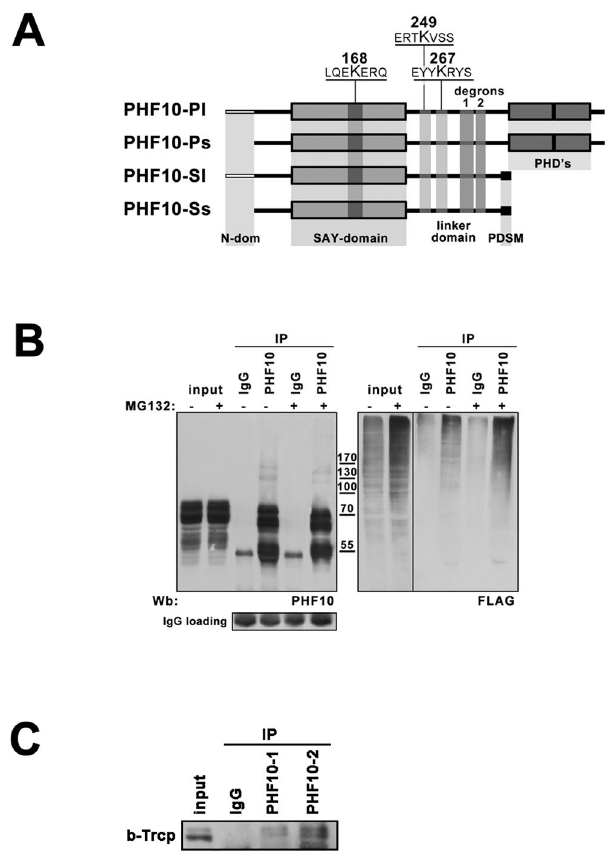
Figure 3. PHF10 is degraded via β -TrCP targeted ubiqutination. ( A ) The schematic representation of localization of ubiqutination sites and β -TrCP degrons within PHF10 isoforms. Sequences containing ubiquitinated lysines (according to Phosphosite database) are underlined. The ubiquitinated lysines and β -TrCP degrons are common for all PHF10 isoforms. ( B ) The HEK293 cells were transfected with FLAG- ubiquitin and treated (if indicated) with 10 µ M MG132 for 8 hrs. Then PHF10 was immunoprecipitated from control and treated HEK293 extracts with Protein A –Sepharose bound anti-PHF10 antibodies. IgG coupled to protein A Sepharose was used as a control of unspecific precipitation. Western blot of ubiquitinalated PHF10 was developed with anti-PHF10 (left panel) and anti-FLAG (right panel) antibodies. The antibody against the light chain of IgG was used as secondary antibody. The lower panel demonstrates the same Western blot developed with only secondary antibody to demonstrate that equal amounts of antibodies were used for immunoprecipitation. ( C ) PHF10 and β -TrCP interact in HEK293 extract. Immunoprecipitation of β -TrCP from HEK293 extracts with antibodies against PHF10. IgG coupled to protein A Sepharose was used as a control of unspecific precipitation. The precipitated proteins were resolved by SDS-PAGE and visualized by Western blotting. The images in Fig. 3(B and C) are cropped. The full length of Fig. 3B is presented in Supplementary